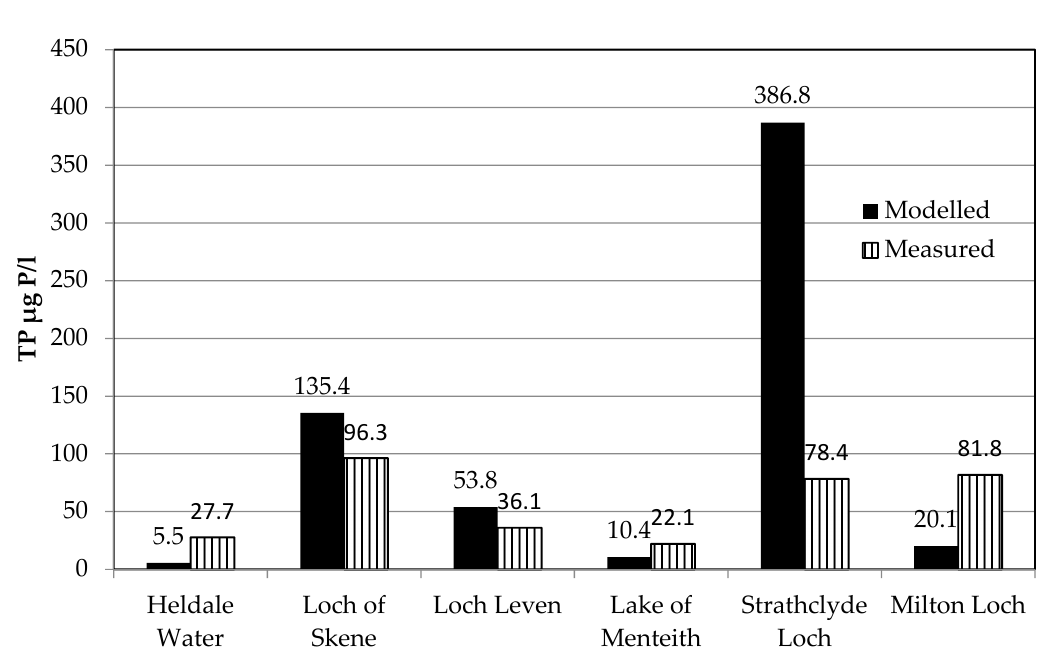
Table 4. Matrix of the number (and percentages) of modelled and measured standing waters within each WFD class.